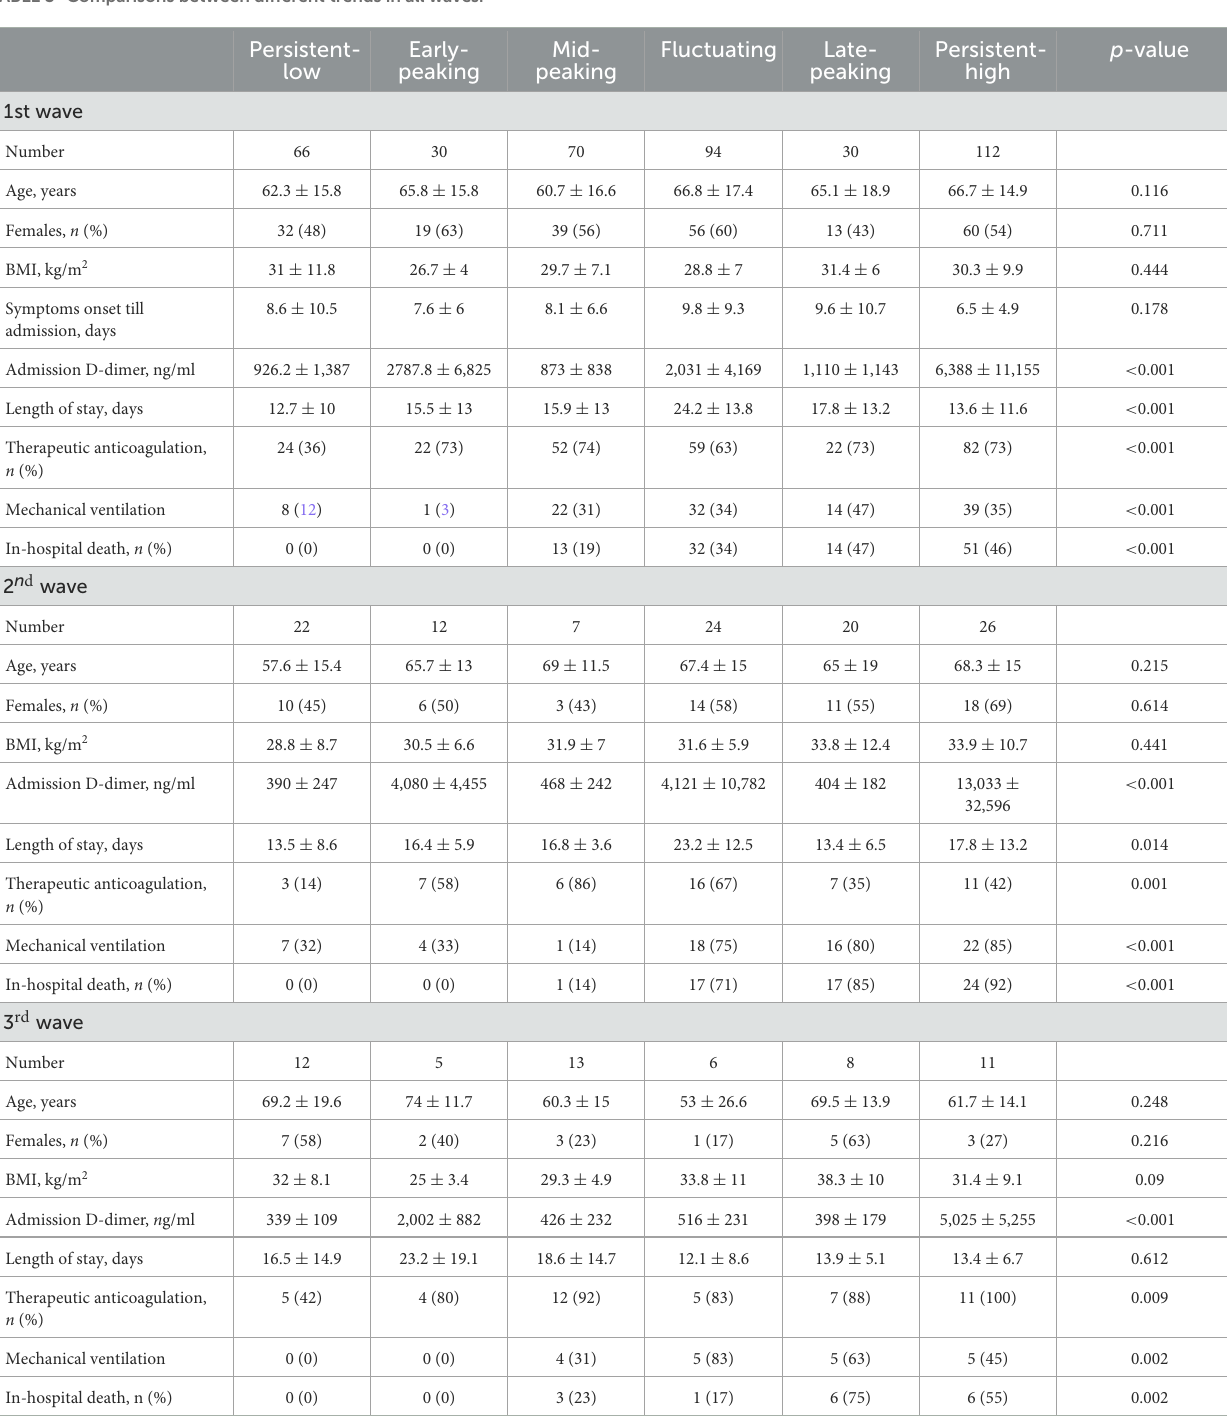
TABLE 3 Comparisons between different trends in all waves.